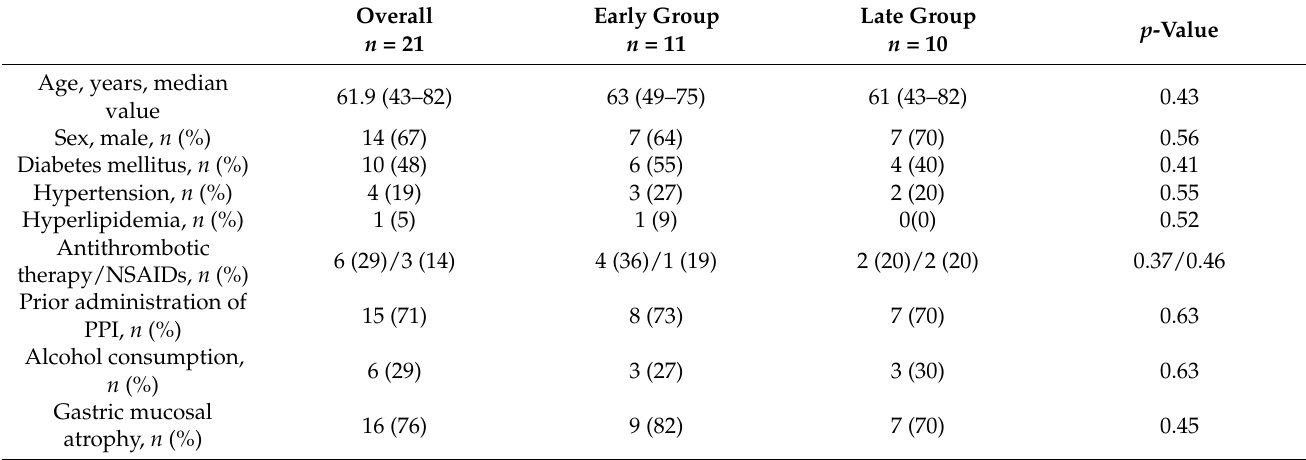
Table 4. Factors associated with early bleeding in the follow-up group.